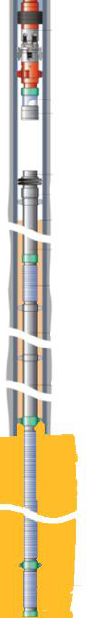
Figure 10. Correct overhead technical equipment of a gas well at its mouth, (source: elaborated by authors).